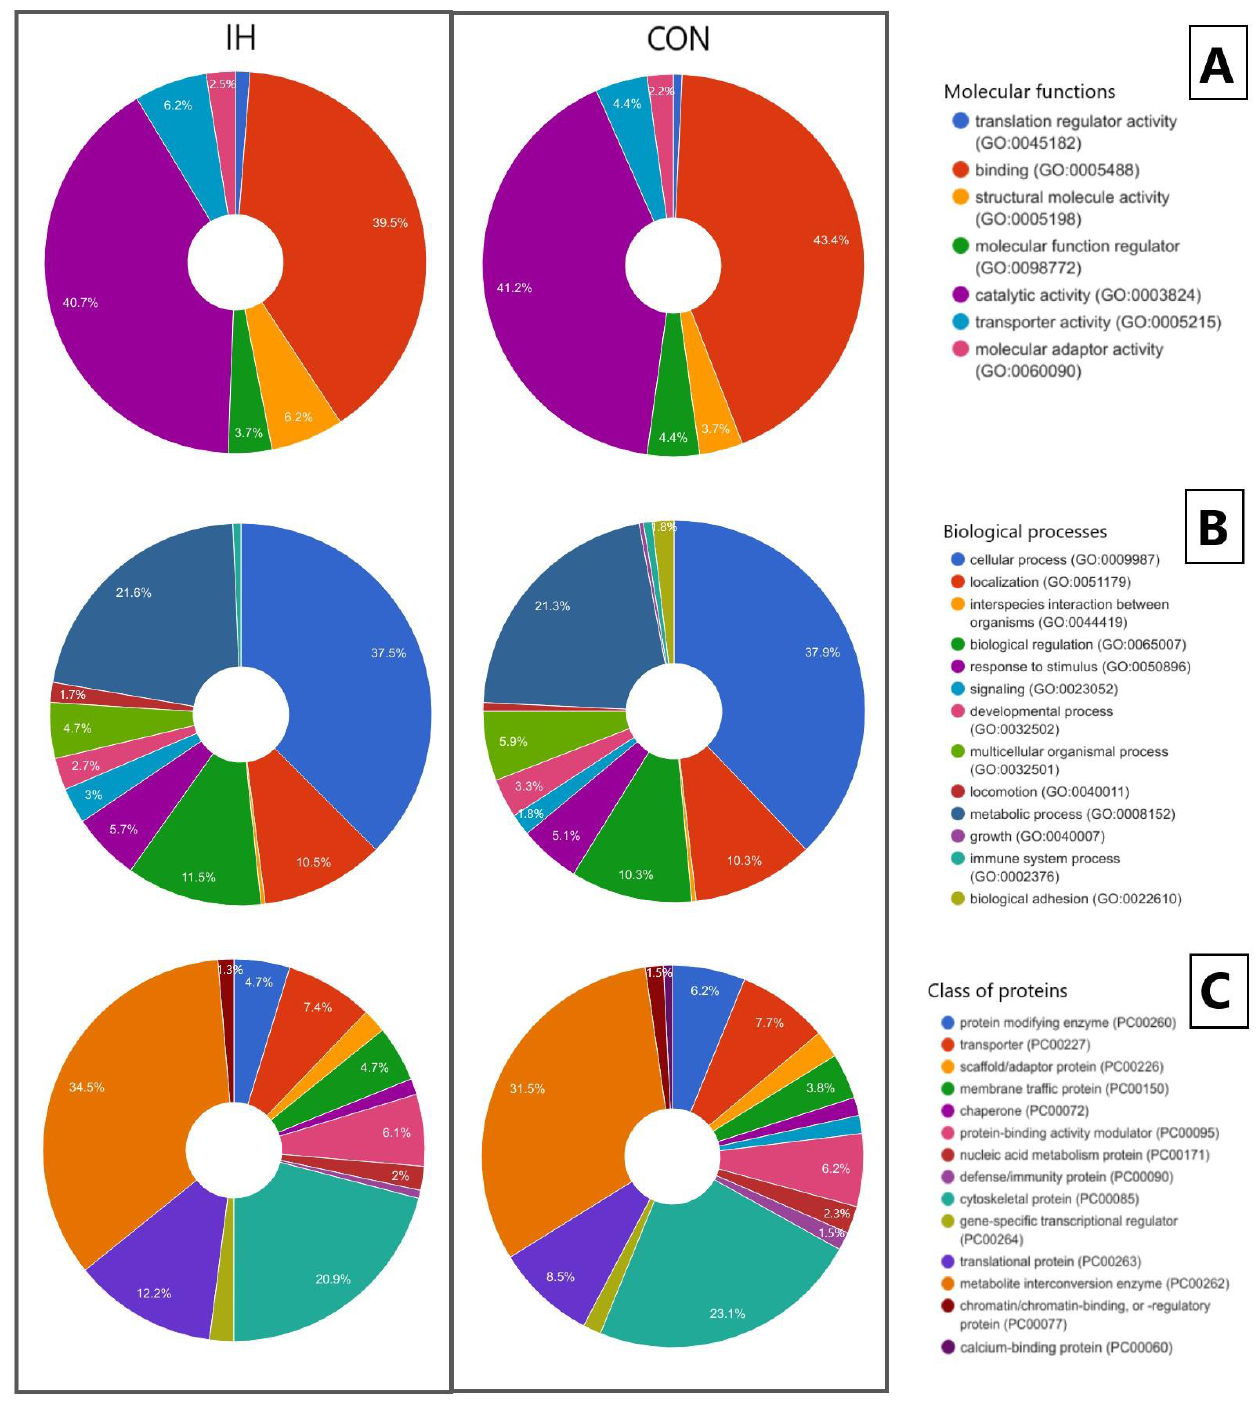
Figure 7. The PANTHER classification of the identified proteins in porcine muscle by molecular function ( A ), biological processes ( B ) and class of proteins ( C ).